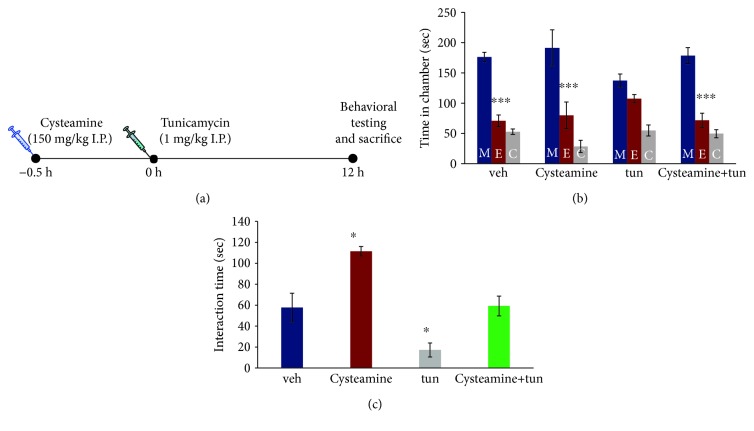
TG2 inhibitor, cysteamine, attenuates ER stress-induced social interaction deficits in mice. (a) Treatment paradigm. Adult male mice were injected intraperitoneally with tunicamycin (1 mg/kg in dimethyl sulfoxide, DMSO), vehicle (DMSO), or cysteamine (cys; 150 mg/kg, 30 minutes before tunicamycin injection) and tunicamycin (1 mg/kg in DMSO). Behavior was performed 12 hours after tunicamycin injection. (b–c) Cysteamine pretreatment attenuated tunicamycin-induced deficits in social behavior. (b) The three-chamber social interaction test. ∗∗∗p < 0.001 (E vs. M); two-way ANOVA. (c) Reciprocal social interaction test. ∗p < 0.05 vs. veh group; two-way ANOVA. (b–c) N = 6 (vehicle); 6 (tun), 4 (cysteamine), and 6 (cysteamine + tun). Data are expressed as mean ± SEM. M: chamber housing stranger mouse; E: chamber housing an empty cage; C: center.